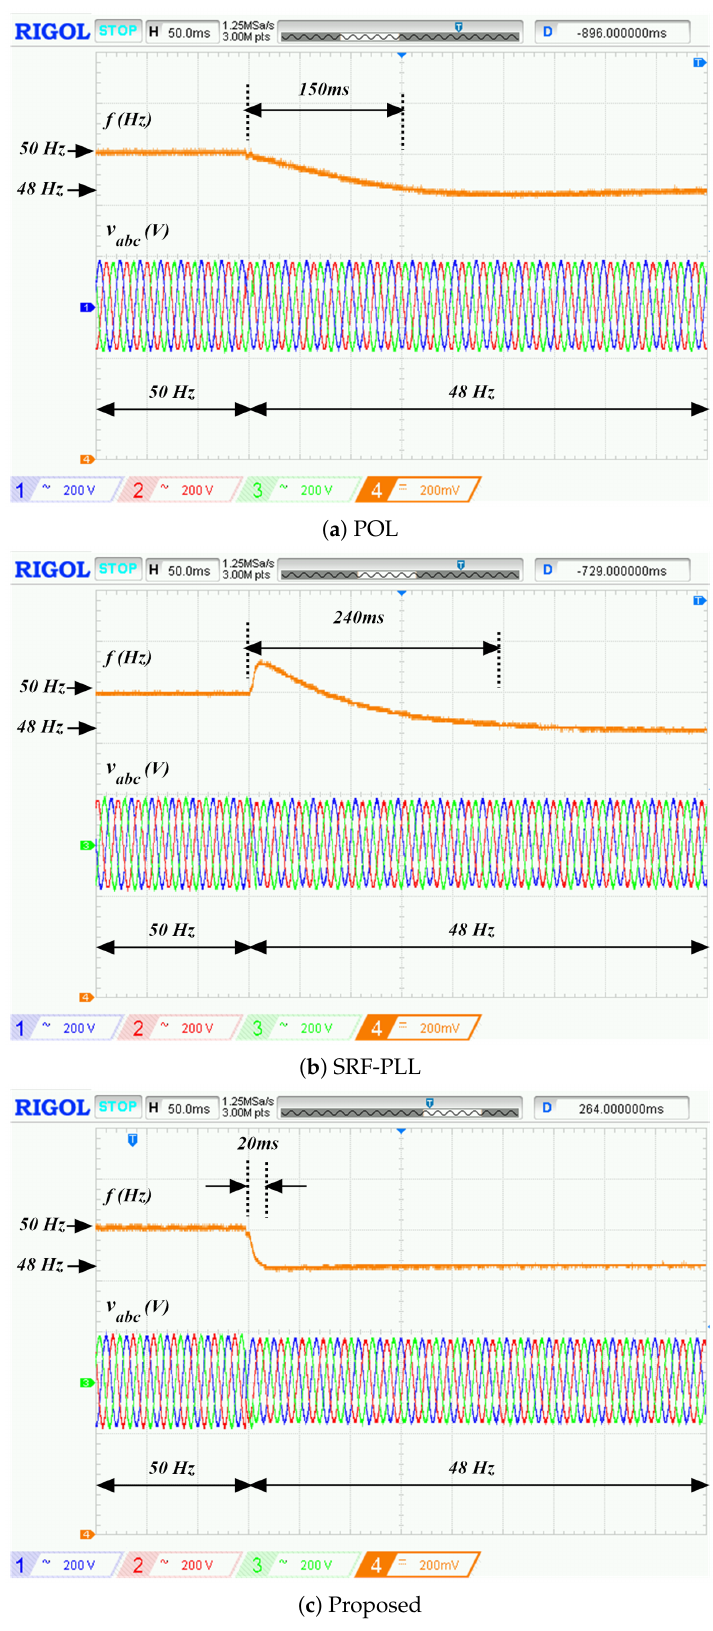
Figure 10. Comparative experimental results for a − 2 Hz frequency step